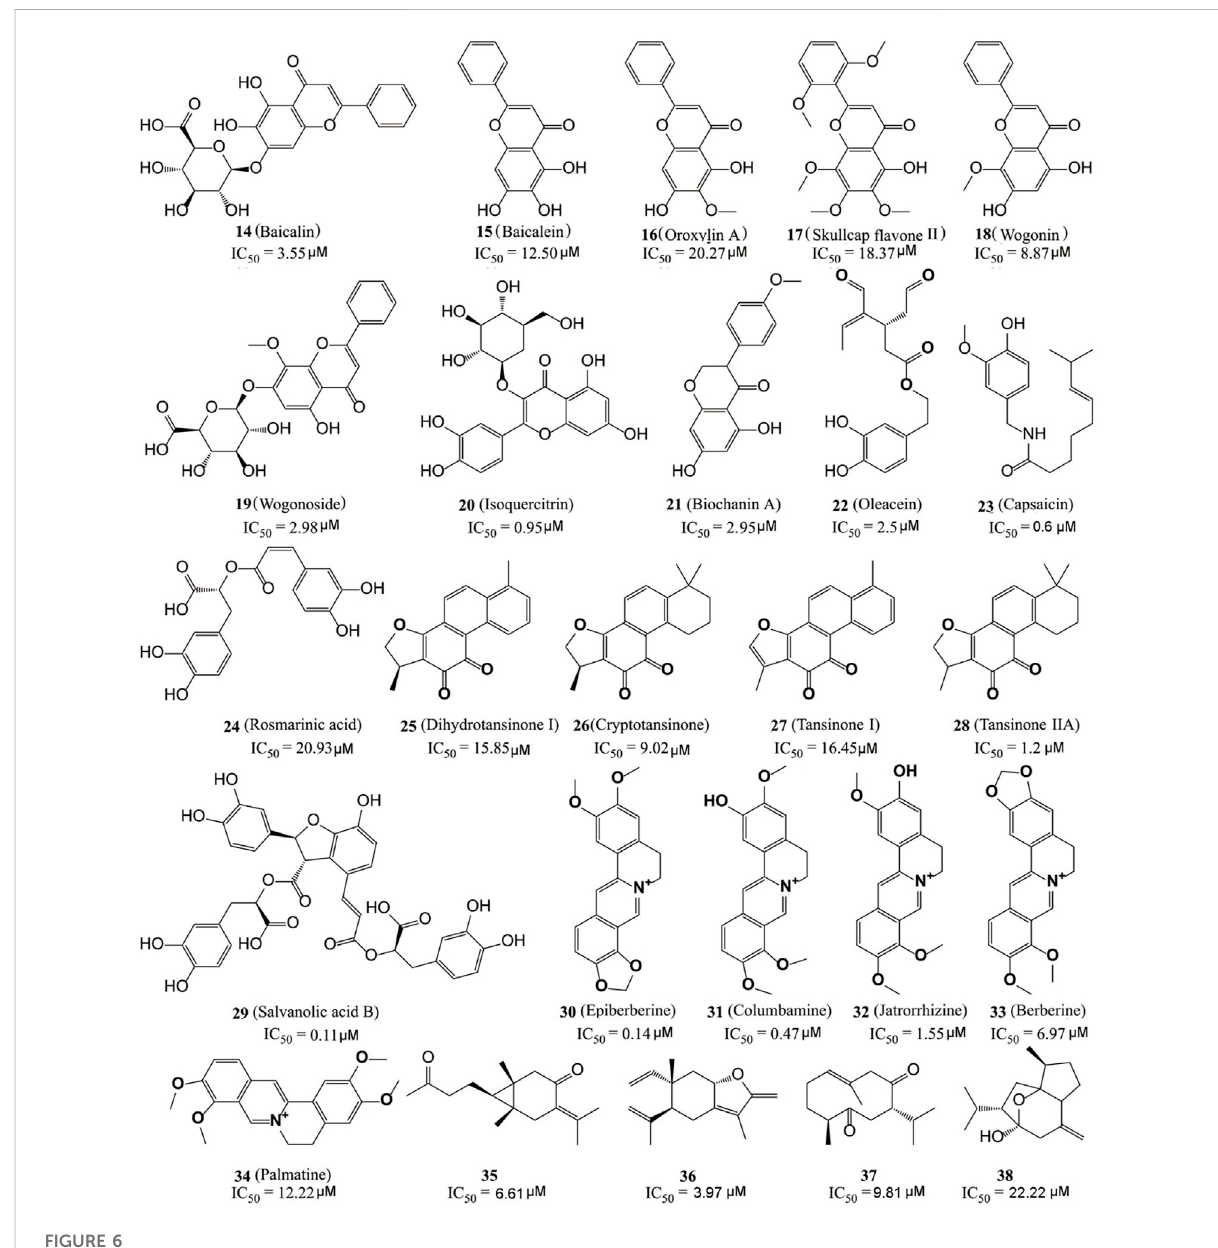
FIGURE 6 Structure of natural LSD1